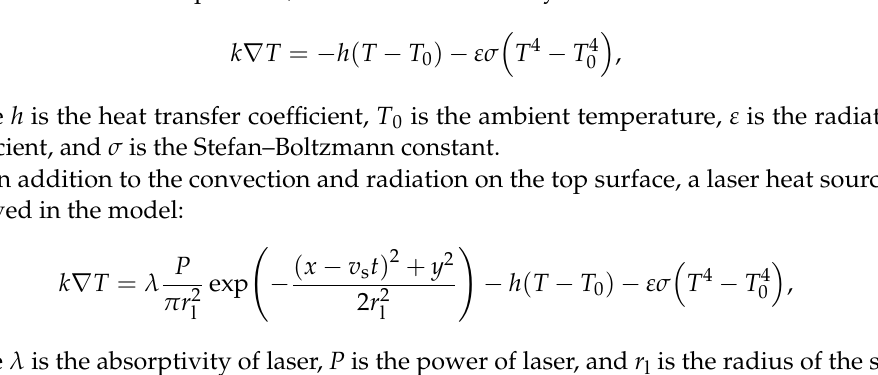
Table 2. Material properties used in the numerical simulation.